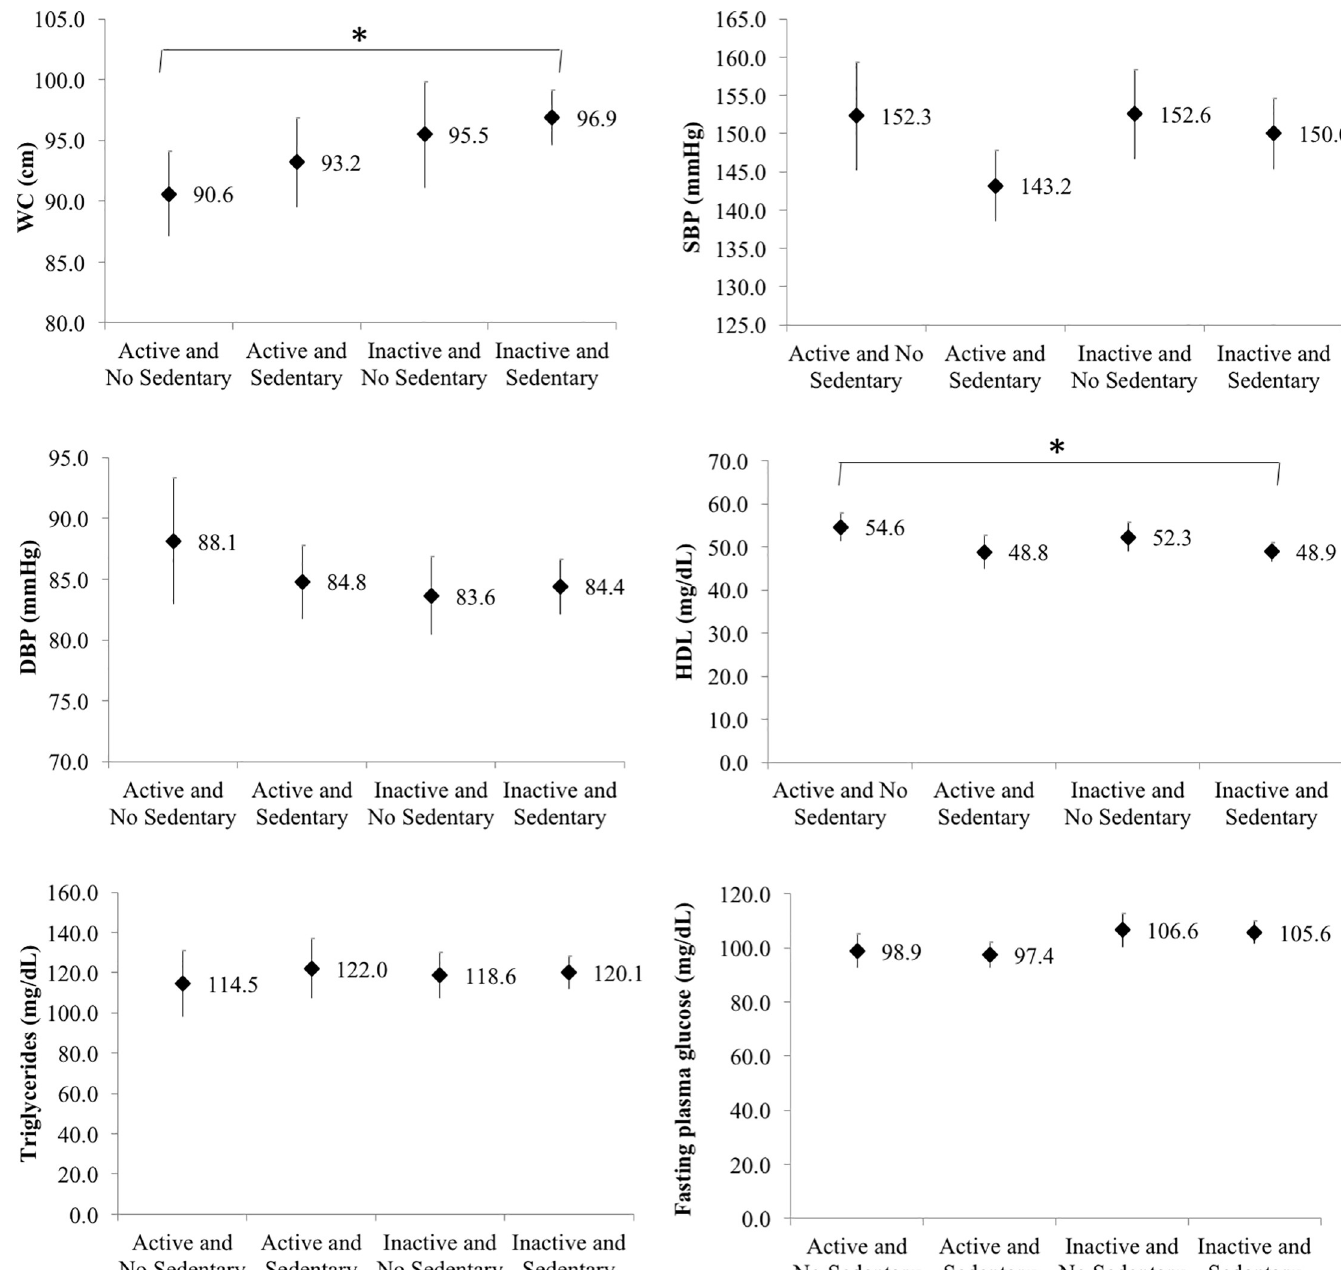
Fig 1. Means values of cardiometabolic variables according to the simultaneity of physical activity and sedentary behavior in Brazilian older adults. Floriano´polis, Brazil, 2015. WC = Waist Circumference; SBP = Systolic Blood Pressure; DBP = Diastolic Blood Pressure; HDL = High density lipoprotein cholesterol. � p < 0.05.